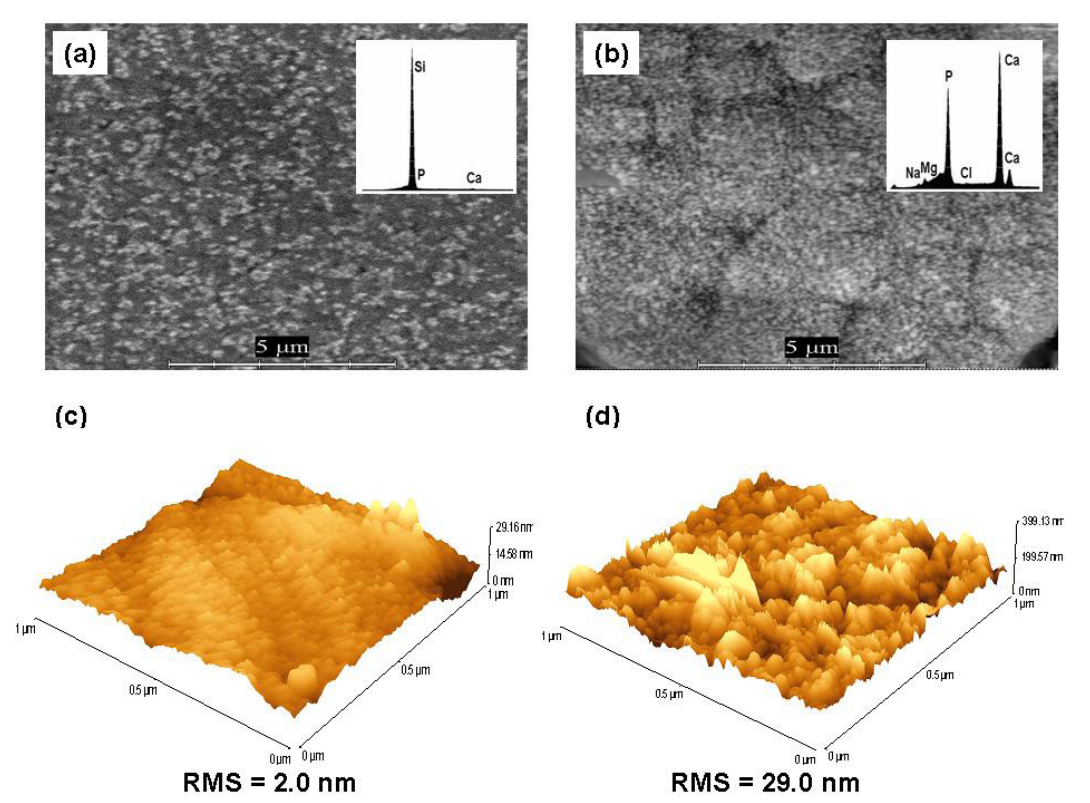
Figure 2. SEM - EPMA surface analysis (a, b) and AFM images (c, d) of glass samples (a, c – G0, b, d – G14) after 7-day immersion in